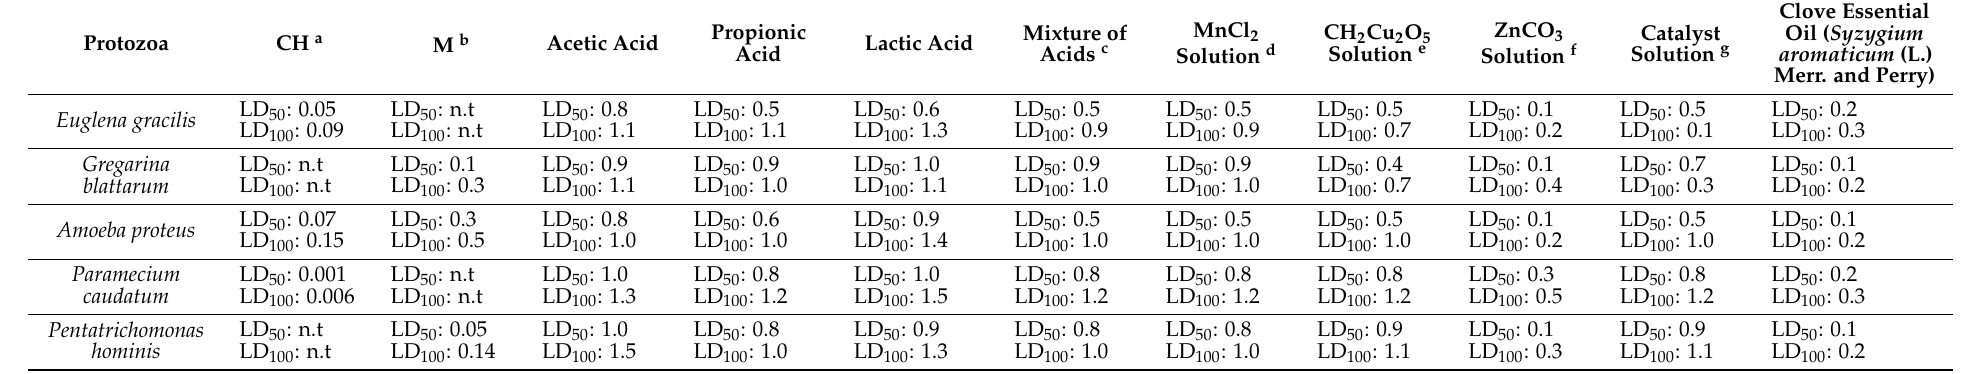
Table 2. LD 50 , LD 100 values [%] of clove essential oil ( Syzygium aromaticum (L.) Merr. and Perry) and the components used in the study.